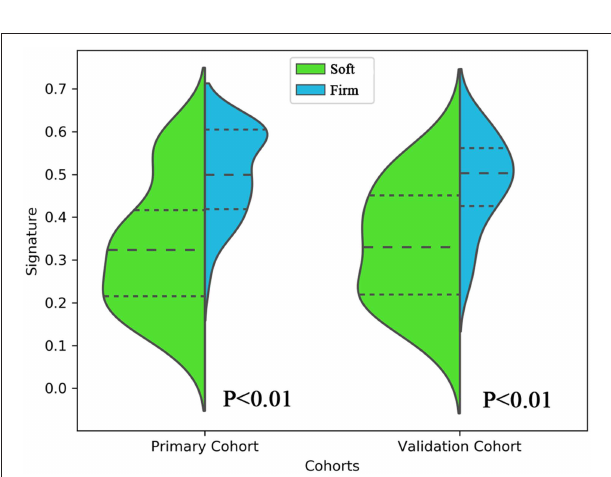
FIGURE 3 | Violin plot comparing the distribution of the radiomics signatures of soft and firm tumors in the primary and validation cohorts. This plot is a combination of a boxplot and kernel density estimate. The signature distributions of each cohort were compared using independent-samples t